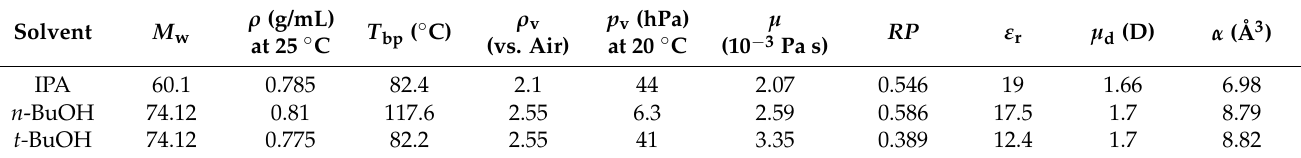
Figure 4. SEM images of the thin film perovskite FAPbI 3 prepared by two-step method using various solvents for FAI: ( a ) IPA, ( b ) n ‐ BuOH and ( c ) t ‐ BuOH. Table 2. Selected properties of the solvents used for FAI ( M w —molar mass, ρ —density, T bp —boiling point, ρ v —vapor density, p v —vapor pressure, µ —viscosity, RP —relative polarity, ε r —electric permit- tivity, µ d —dipole moment, α